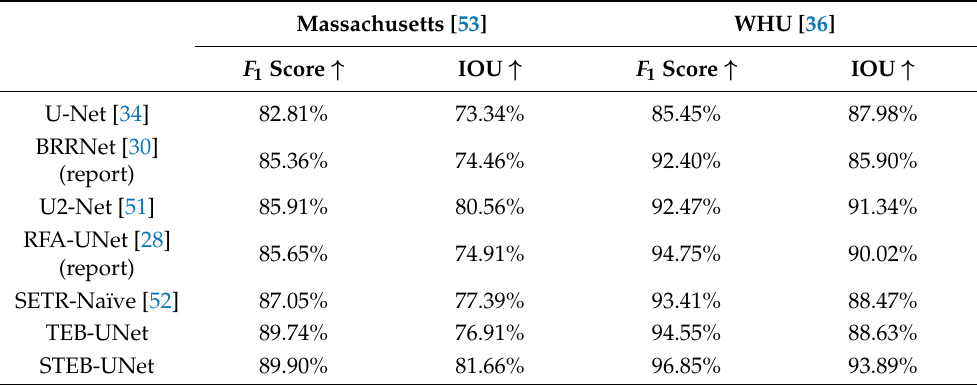
Table 2. Experimental results of different methods on WHU and Massachusetts